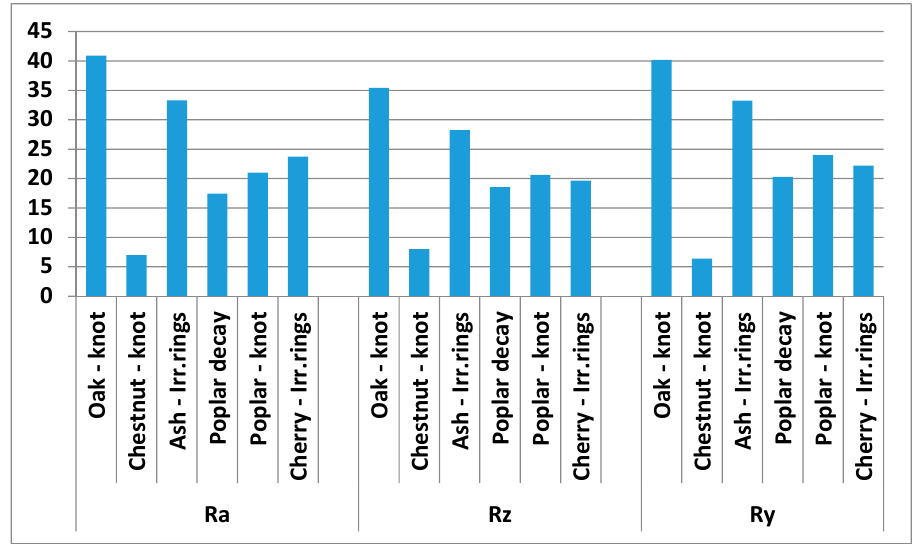
Figure 13. Percentage values depicting the differences between roughness parameters Ra, Rz and Ry of typical wood structure veneer surfaces and non-typical structure areas around the defects (decreased around the defects).